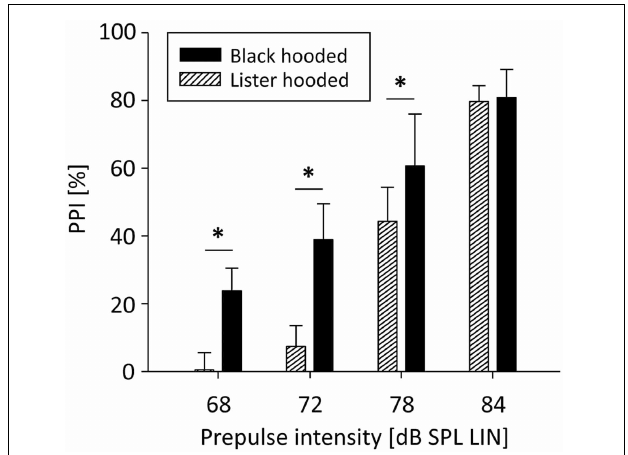
FIGURE 1 | PPI depends on prepulse intensity and hearing capacity. PPI of Lister and Black hooded rats was a function of prepulse intensity. For low prepulses, PPI was significantly stronger in well-hearing Black hooded rats compared to hearing-impaired Lister hooded rats. For the loudest prepulse, PPI was the same in both strains ( ∗ p ≤ 0 .